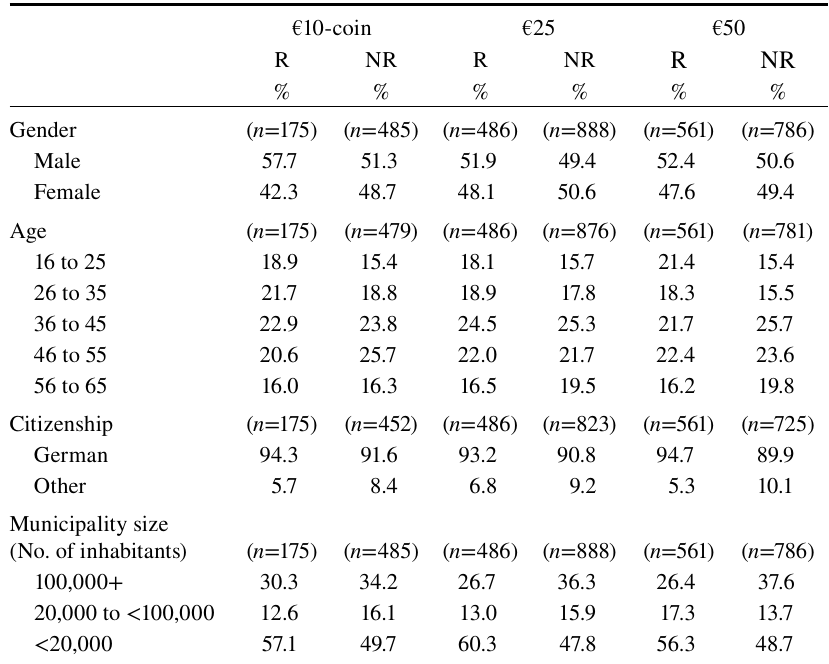
Table A1.1 Distributions of socio-demographic variables for respondents